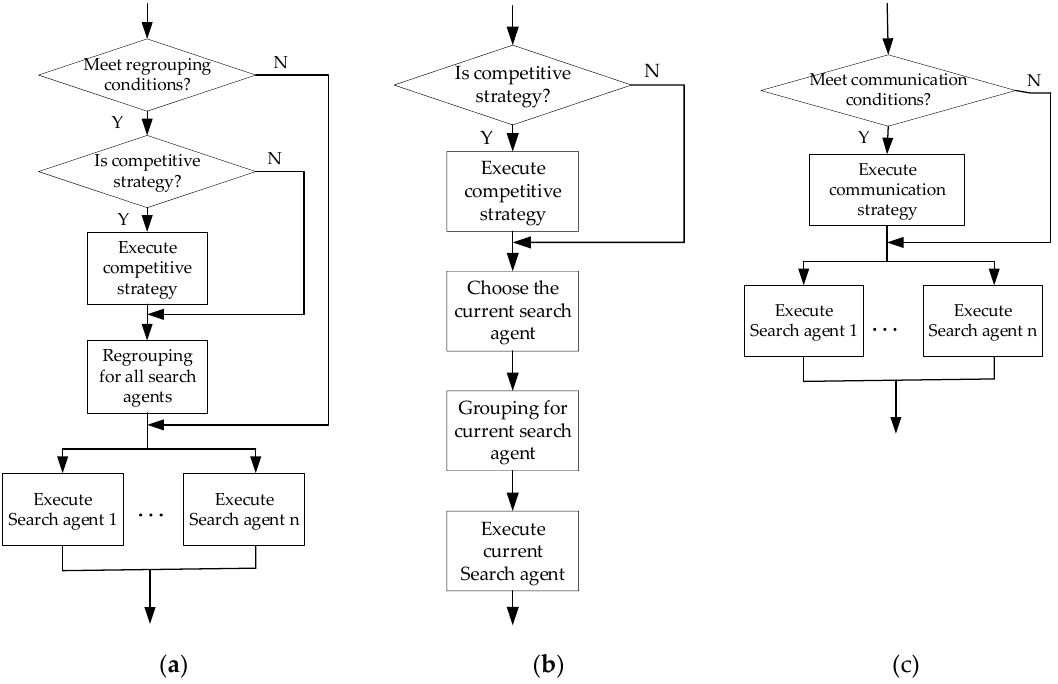
Figure 3. The flow charts of three combination mode components in one iteration: (a) Individual level